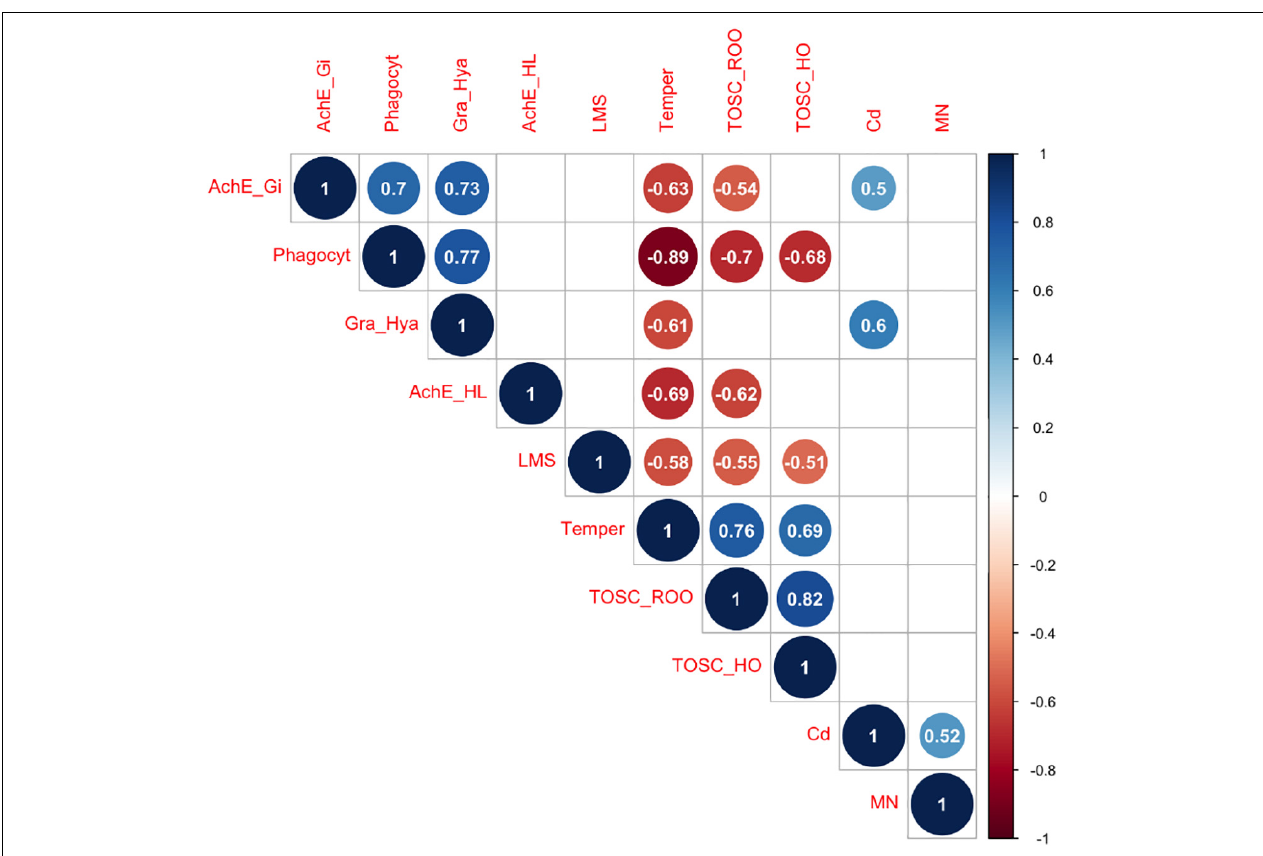
FIGURE 4 | Pearson correlation heatmap showing correlation coefficients—blue and red indicate positive and negative correlation, respectively. Only significant correlations ( p < 0.05) are shown.